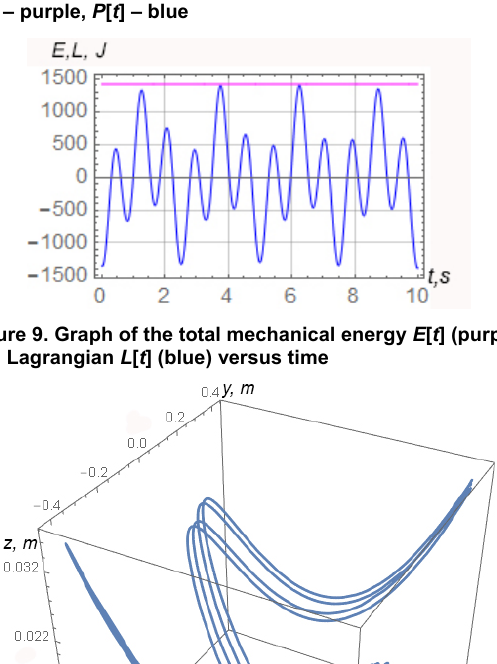
Figure 5. Dependency graph θ [ t ]